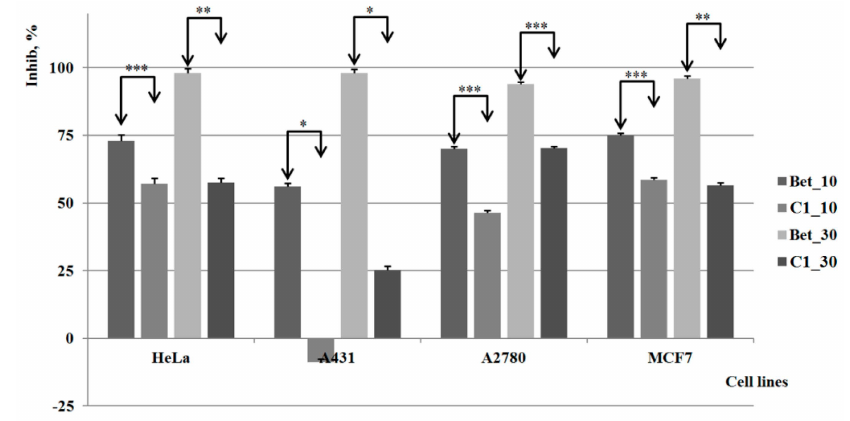
Figure 4. The results of the in vitro tests for C1 vs. control group (Bet) *, **, *** indicate p < 0.05, p < 0.01, and p < 0.001.